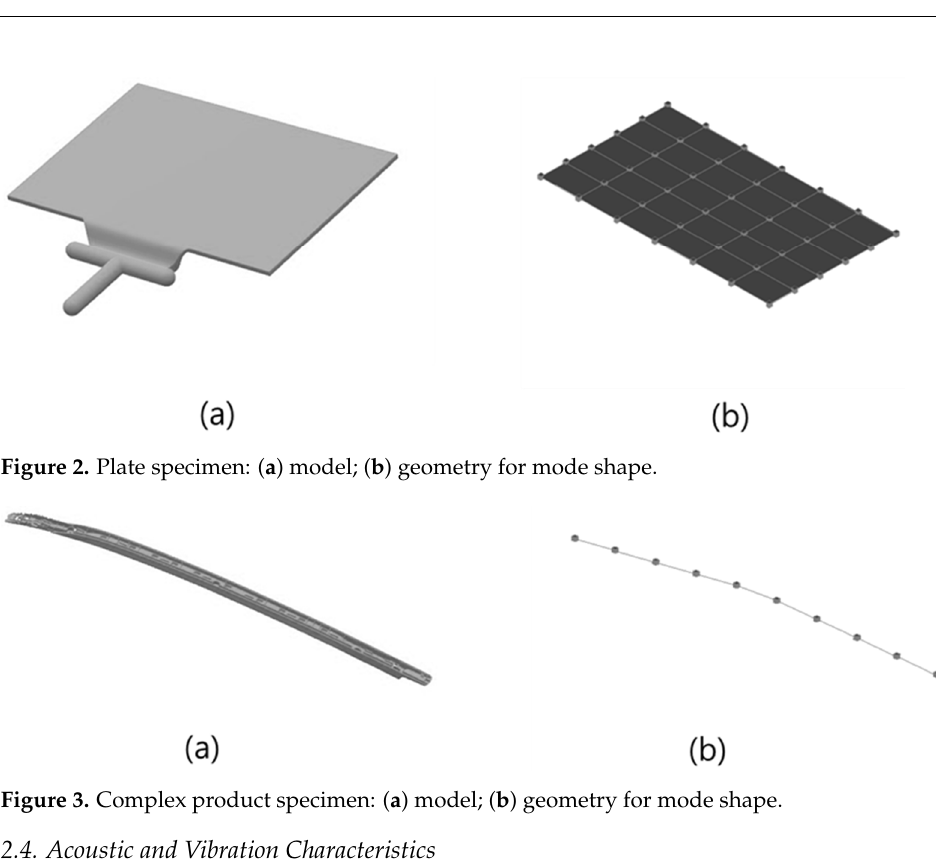
Figure 3. Complex product specimen: ( a ) model; ( b ) geometry for mode shape.